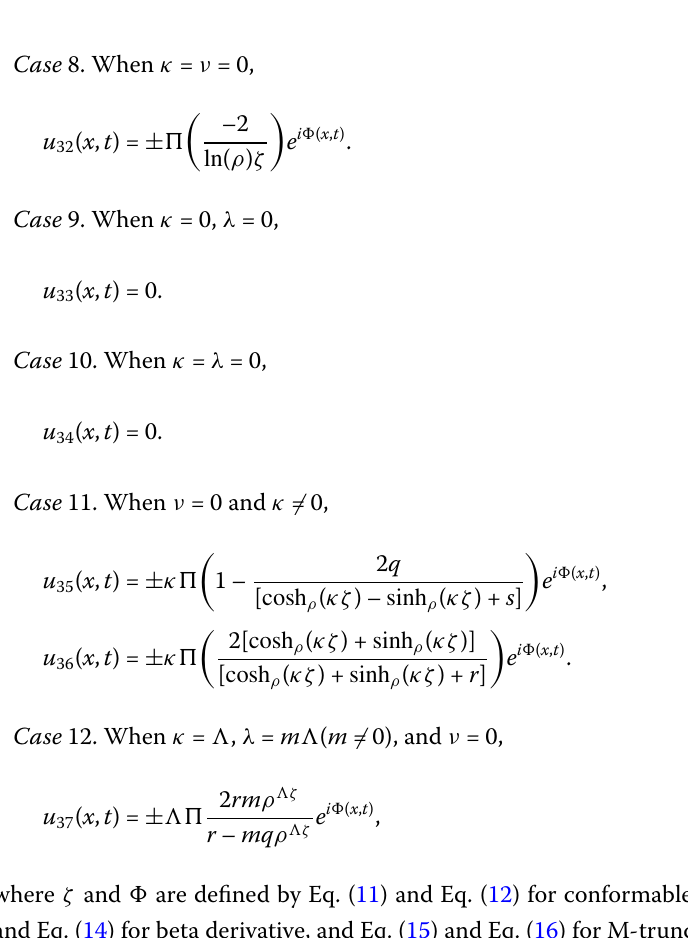
Figure 1: In this figure, we took a = 1, ρ = 2, c = 1, α = 0.5, κ = 1, λ = 1, ν = 1, v = 1, k = 1, P = 1, θ = 1 in u 1 ( x , t ) where 1(a) represents its 3D shape with conformable derivative definition, 1(b) shows its behavior with beta derivative, while 1(c) presents its graphs with M-truncated derivative with β = 0.9. Figure 1(d) represents a 2D-graph of u 1 ( x , t ) at t =